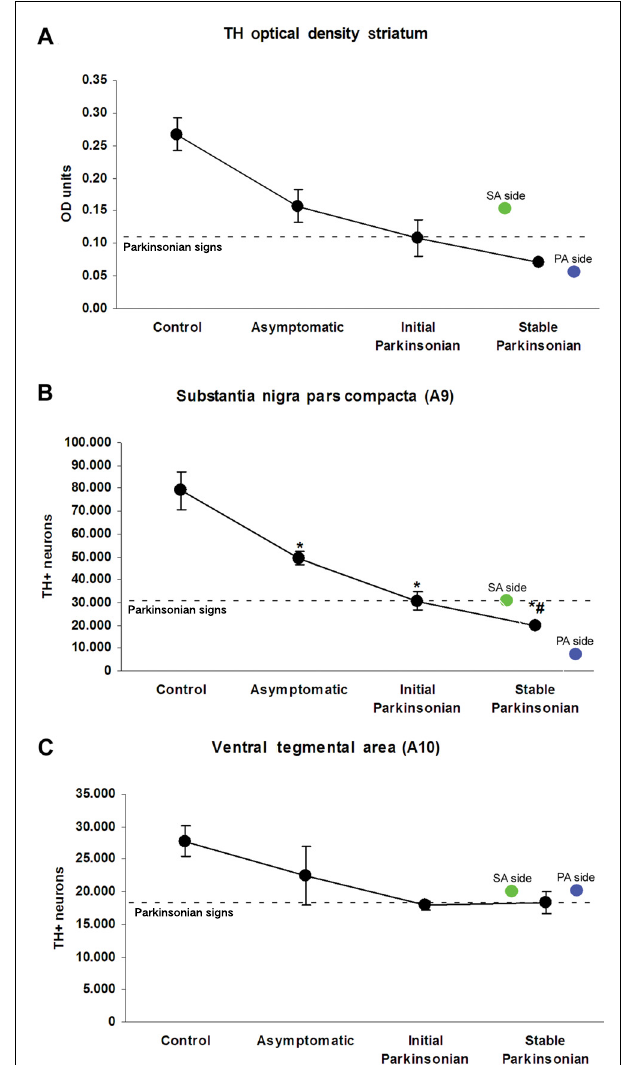
FIGURE 4 | Tyrosine hydroxylase (TH) immunostaining in the striatum and mesencephalon. (A) Line graph showing progressive reduction in the optical density (OD) quantitative analysis ofTH immunostaining in the striatum. Line graphs showing the effect of 1-methyl-4-phenyl-1,2,3, 6-tetrahydropyridine (MPTP) administration on the number ofTH-positive cells remaining in the substantia nigra pars compacta (A9) (B) , and ventral tegmental area (A10) (C) of control and MPTP-treated monkeys. For comparison, the number ofTH-positive cells remaining in each region and the OD in the striatum of the Primary Affected Side (blue circle) and Secondary Affected Side (green circle) of the asymmetric monkey is shown. Data represent mean ± SEM. Symbols indicate significant differences between groups. * p < 0.01 compared with control; # p < 0.01 compared with